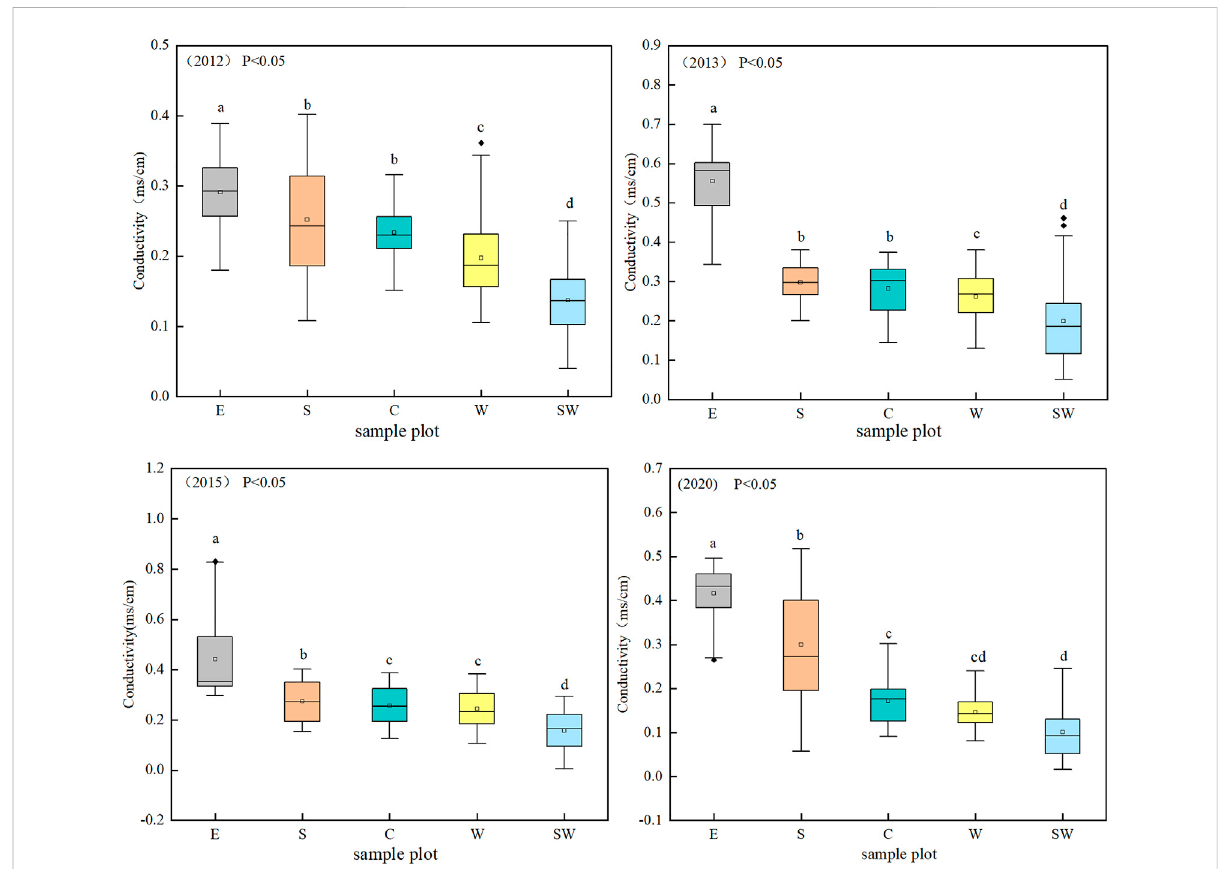
FIGURE 3 Boxplots of water conductivity in various sample plots. Different lowercase letters indicate signi fi cant differences ( p < 0.05).